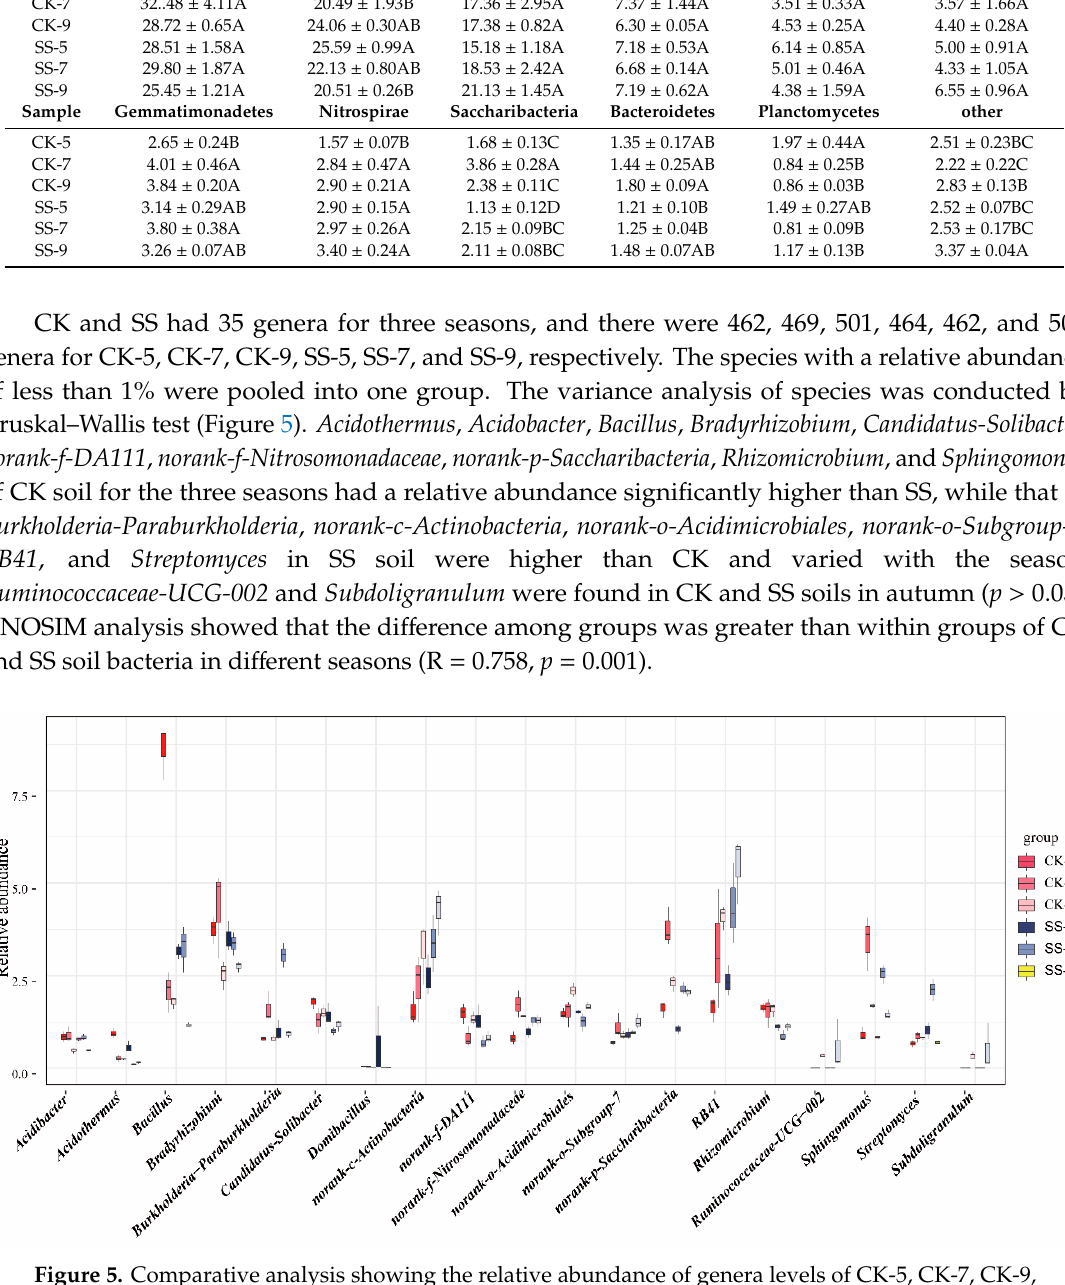
Table 4. Correlation analysis of diversity indices and soil properties. The correlation coefficient and significance were obtained using Pearson’s correlation analysis. Significant values are shown as: * p < 0.05; ** p < 0.01. diversity index